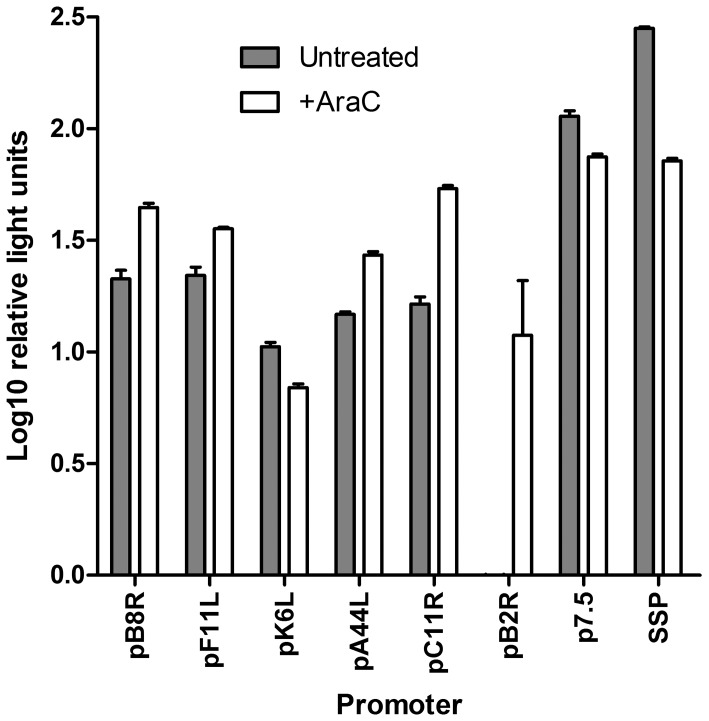
Activity of endogenous promoters compared to p7.5 and SSP in vitro.BHK cells were infected with 1 pfu/cell of recombinant MVA carrying tPA-Pb9-rLuc8PV under the control of the indicated promoters. Renilla luciferase activity in the culture supernatant was quantified at 8 h post-infection. Cells were either untreated (grey bars) or exposed to 40 µM AraC during and after infection (open bars), to inhibit post-replicative gene expression. Data shown are the mean and standard deviation of duplicates after subtraction of signal at 1 h post-infection and are representative of two independent experiments.